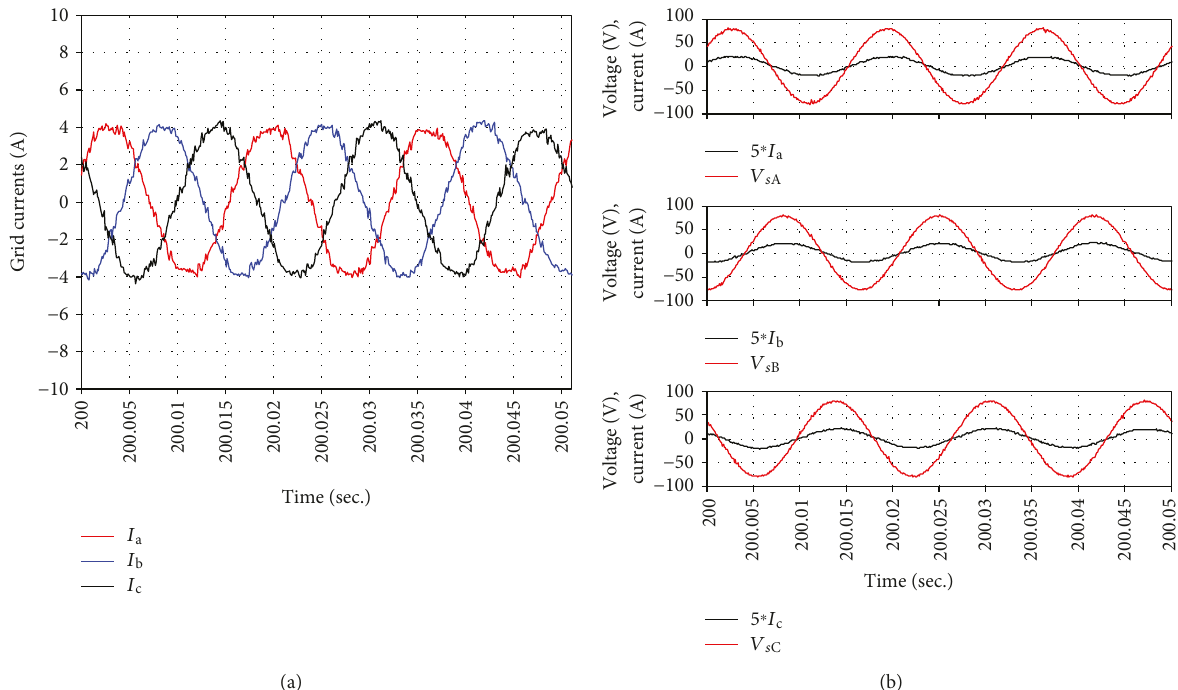
Figure 18: (a) Experimental three-phase grid currents of con fi guration A. (b) Experimental grid voltages and grid currents of con fi guration